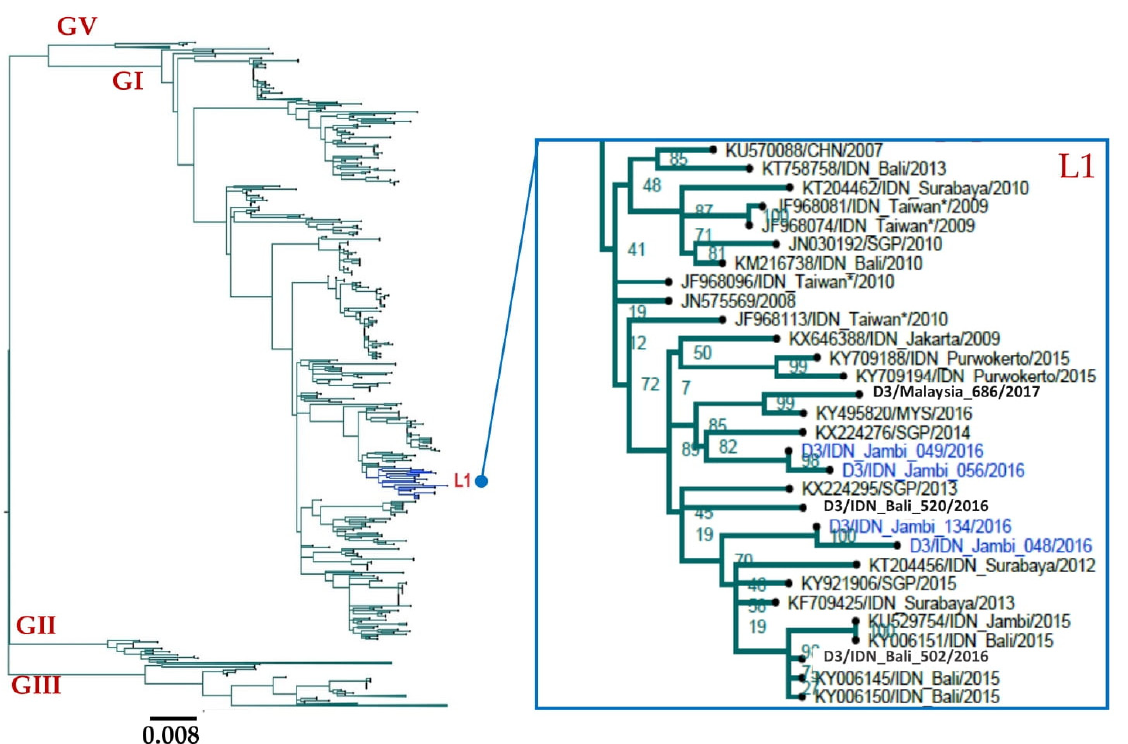
Figure 4. Phylogenetic tree of DENV-3 isolated from Jambi, 2016. The phylogenetic tree was gener- ated using the maximum likelihood method using RAxML with a GTR+ Γ model of an alignment including four viruses from Jambi and 2032 sequences from NCBI. Some phylogenetic clusters have been collapsed to reveal the positions of isolated viruses in more detail. All identified viruses belong to Genotype I and clustered into one lineage (L1). Blue indicates viruses isolated from Jambi. G: